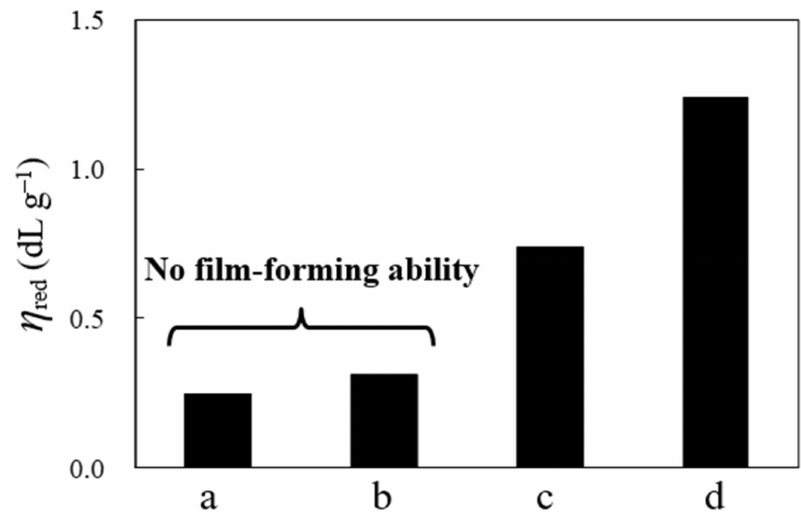
Figure 9. Effects of the polymerization processes on the η red values for the H-PMDA/TFMB system: ( a ) PAA obtained by polyaddition at room temperature; ( b ) PI obtained by chemical imidization; ( c ) PI obtained via the modified one-pot process without catalyst; ( d ) PI obtained using the modified one-pot process in the presence of a catalyst